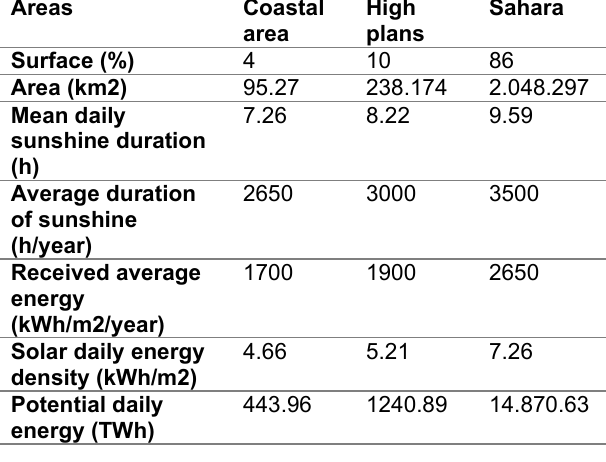
Table 2. Solar potential by climatic region in Algeria